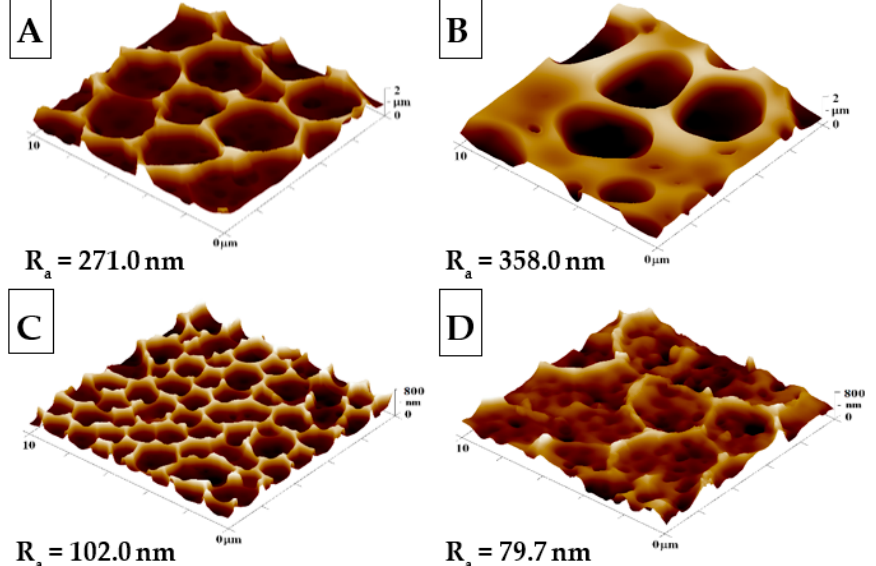
Figure 1. The surface morphologies of the prepared samples: ( A ) honeycomb-like (HCP) structure of the plasma-treated fluorinated ethylene propylene (FEP); ( B ) HCP structure with built-in polyethylene glycol (PEG) with sputtered Ag nanoparticles; ( C , D ) HCP structures with Ag nanoparticles sputtered for 150 and 500 s. The inspected area measured 10 × 10 µm 2 . R a represents the average roughness in nm.